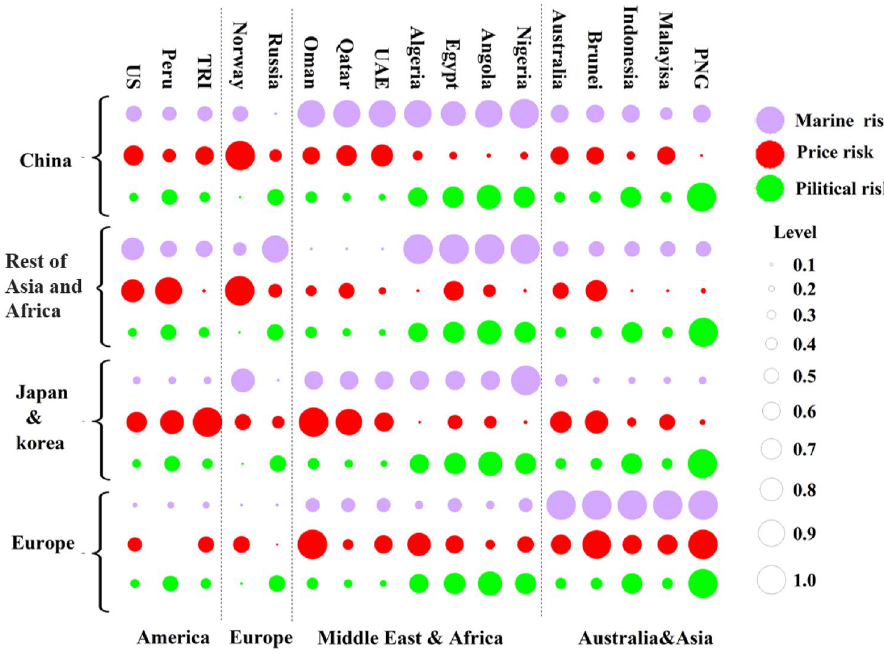
Figure 4. Risk identification of import sources in each LNG import